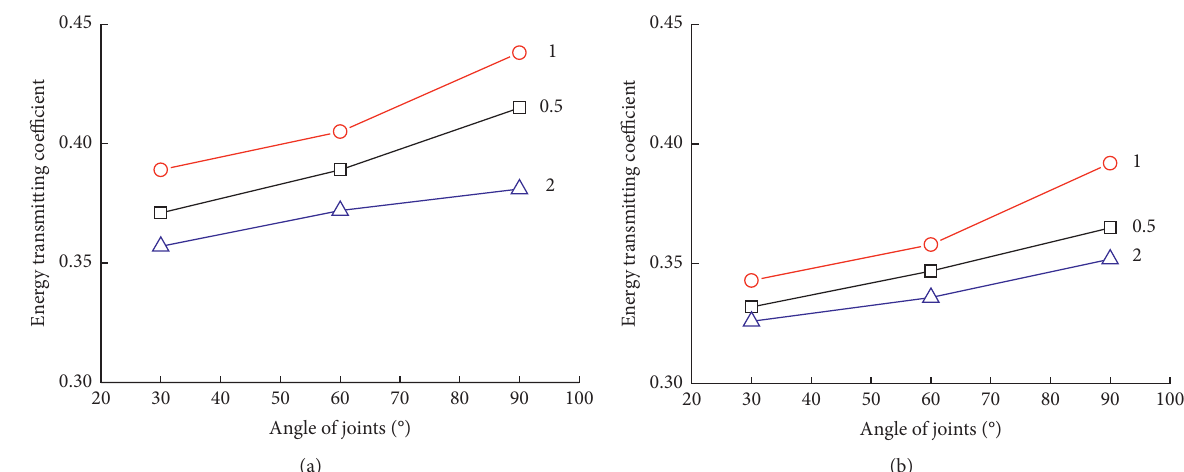
Figure 19: Influence of joint angle on energy transmitting coefficient of stress wave under unequal biaxial static loads. (a) Single-joint rock mass. (b) Double-joints rock